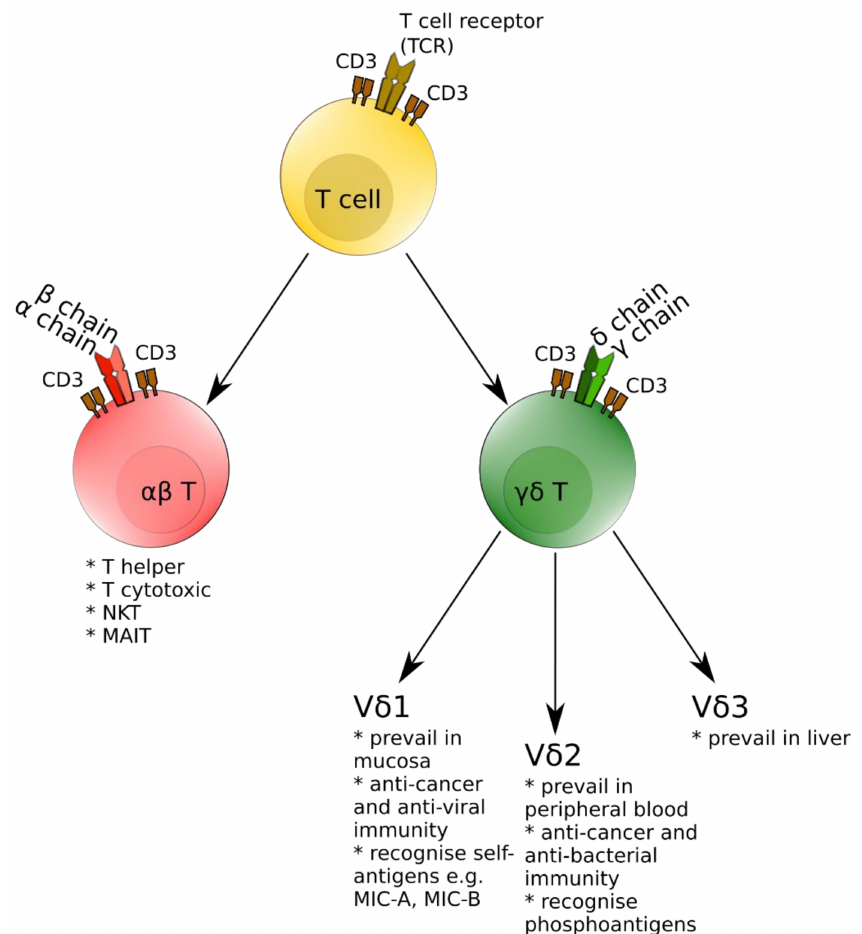
Figure 1. Schematic presentation of major T-cell subsets with special emphasis on γδ T